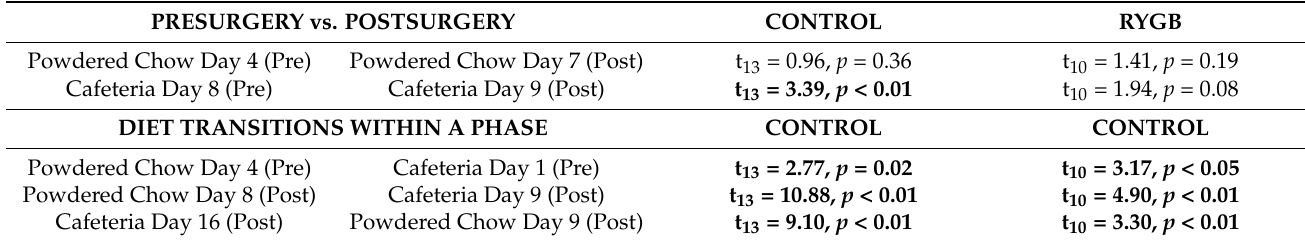
Table 11. Paired t -tests Comparing 22-H Meal Eating Rate within Groups across Diets.